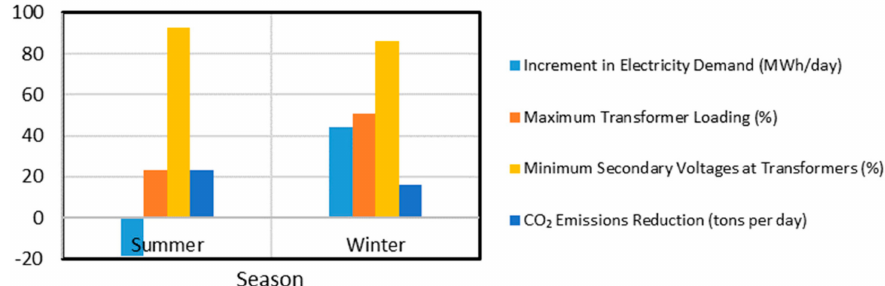
Figure 19. Sensitivity of key variables with respect to the season for DR adoption level at 40% and EV adoption level at